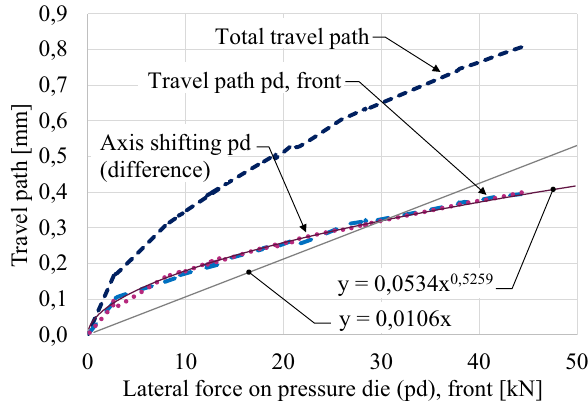
Fig. 16 Experimental setup for stiffness measurement on the bend